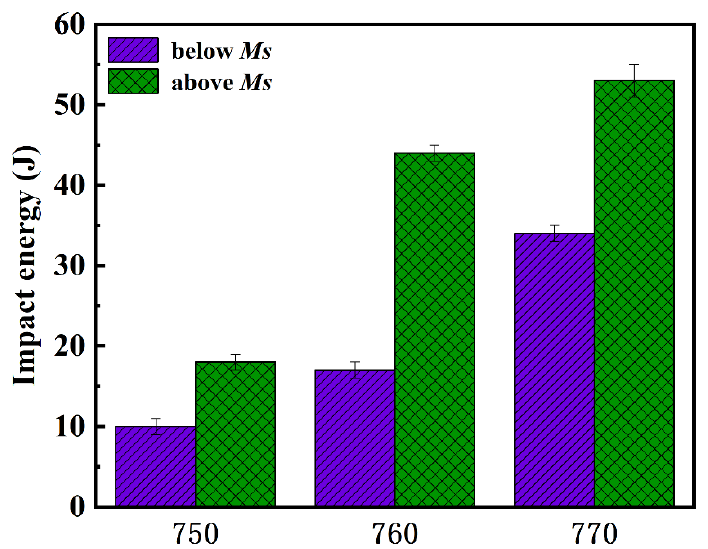
Figure 9. Impact energy after different processes.